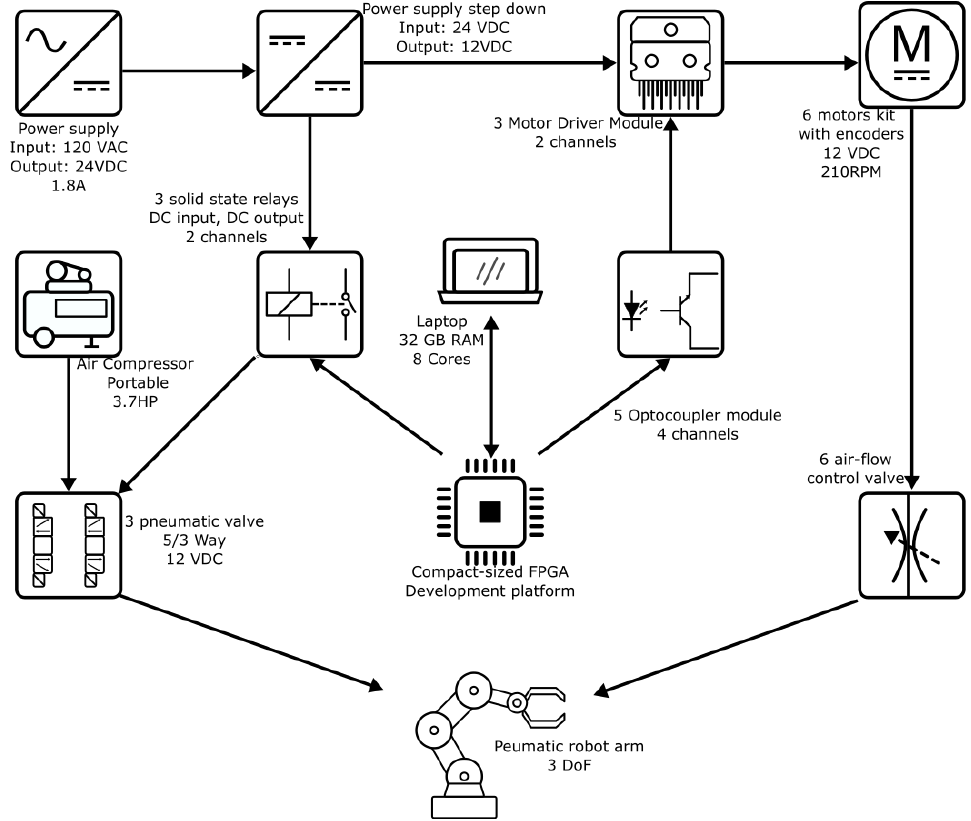
Figure 2. Diagram block of all materials used for this